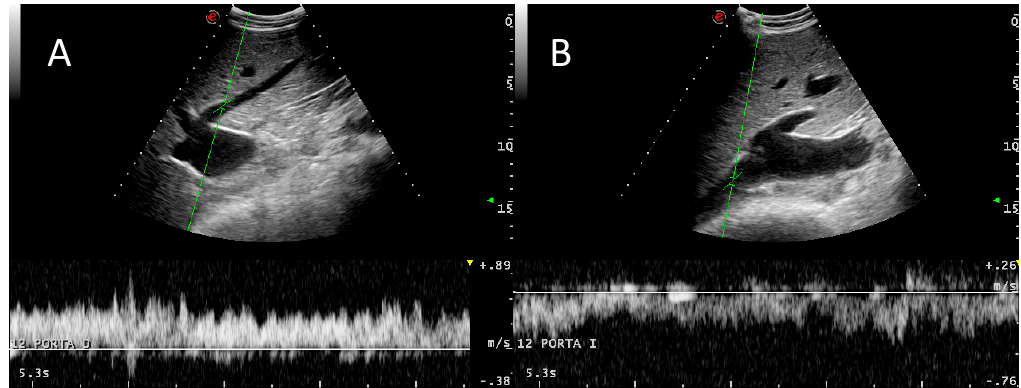
Figure 4. Branching of the main portal vein. ( A ) One of the small branches that emerge from the main trunk and enter the right and middle hepatic lobes. ( B ) The left portal vein is the largest branch that can be easily visualized towards the distal and ventral part of the liver (left lobe). Turbulent flow can be seen in both vessels.